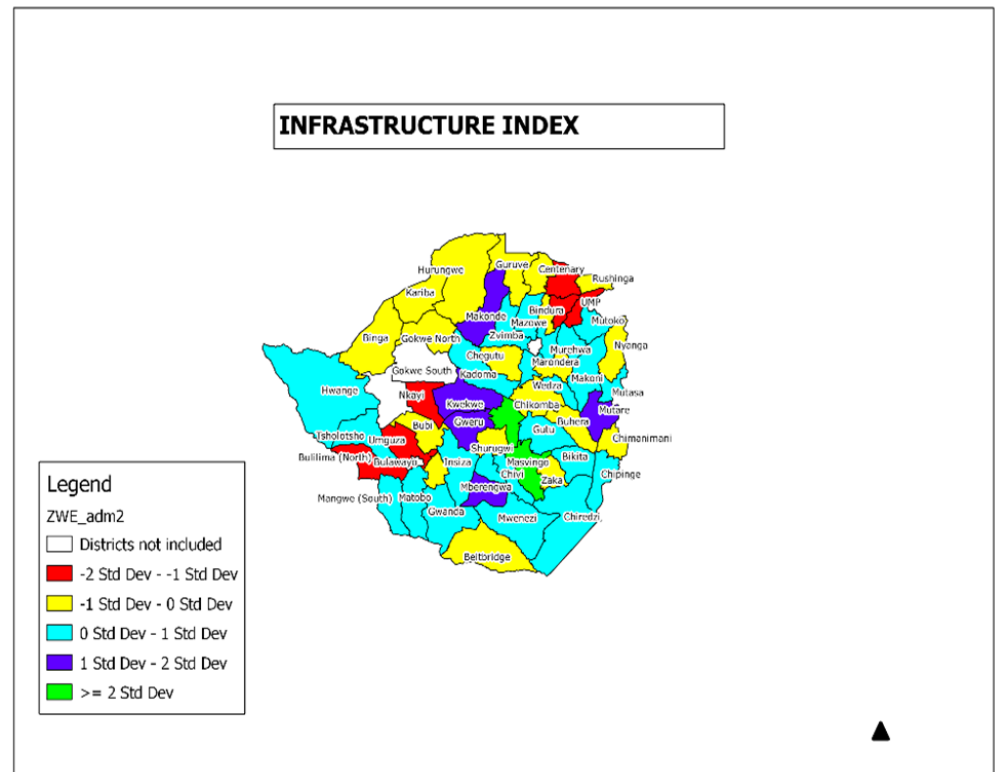
Figure 2b. Spatial Distribution of the Infrastructure